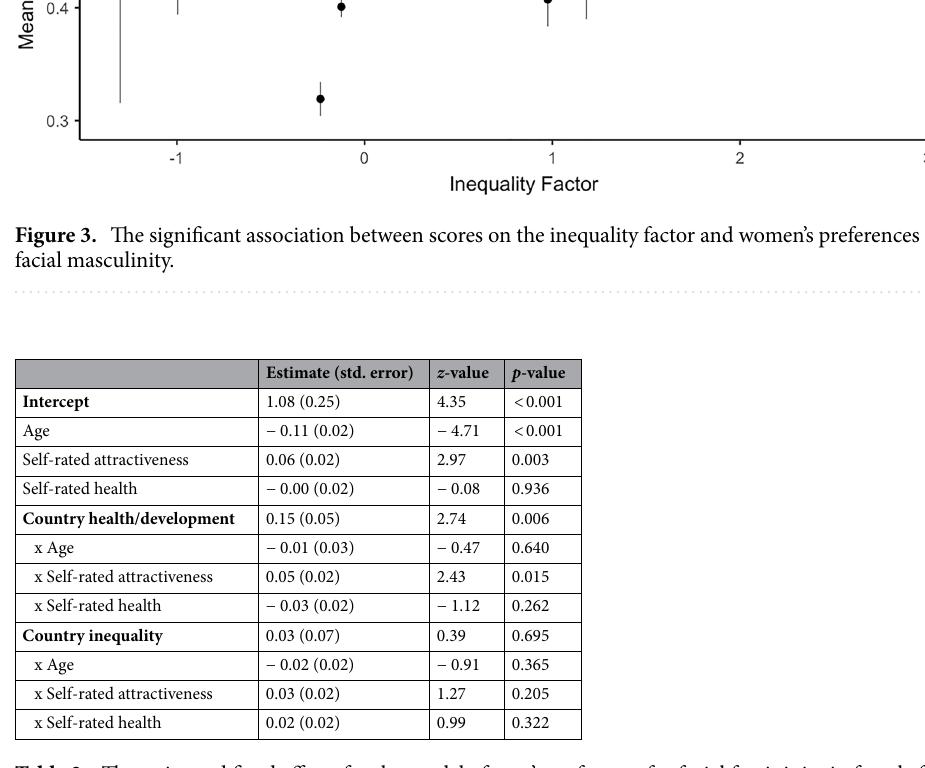
Table 2. The estimated fixed effects for the model of men’s preference for facial femininity in female faces.